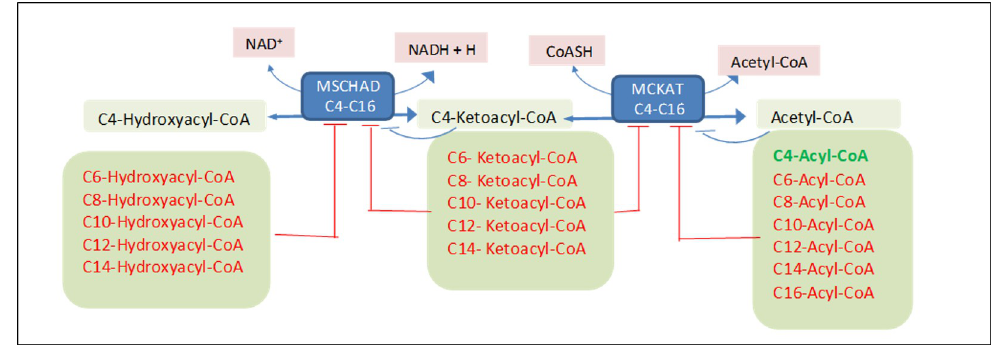
Fig 3. Modular description of the mFAO pathway for one dimensional ODE model. The module includes the conversion to and from C4-Ketoacyl-CoA using MSCHAD and MCKAT enzymes and competitive inhibitory products and substrates of other carbon chain